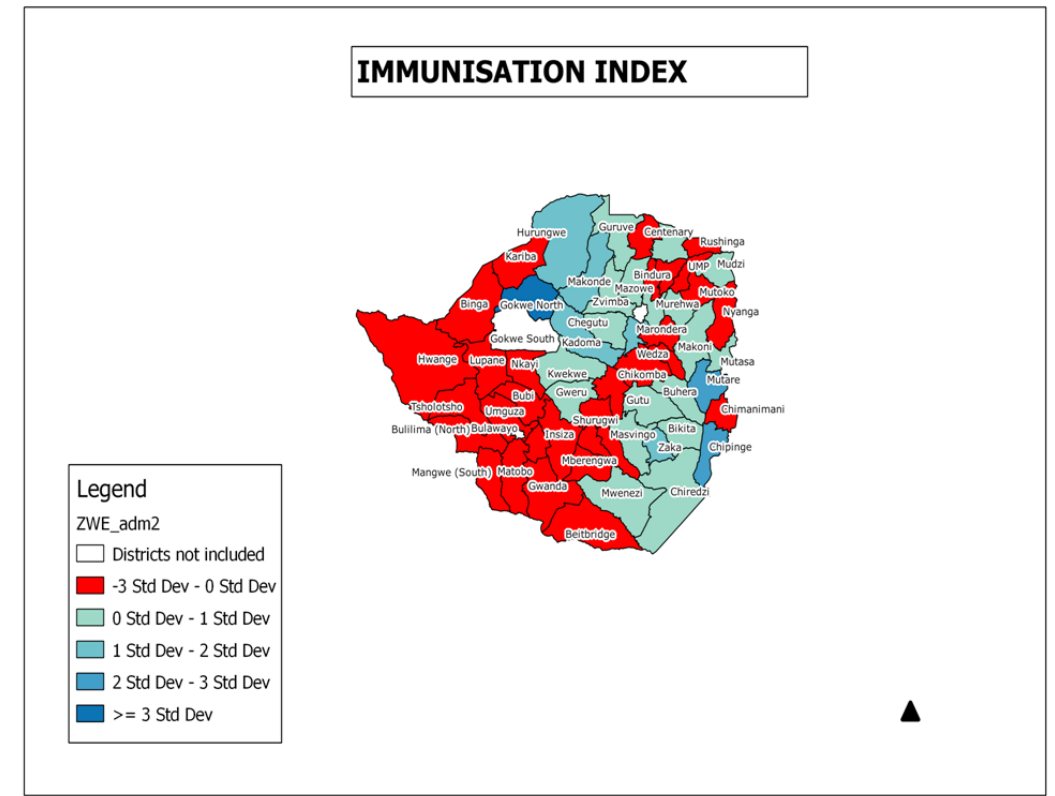
Figure 2a. Spatial Distribution of the Immunisation Index